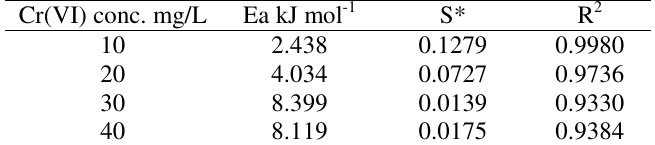
Table 2. Sticking probability and activation energy for the adsorption of Cr(VI) onto MPGP.